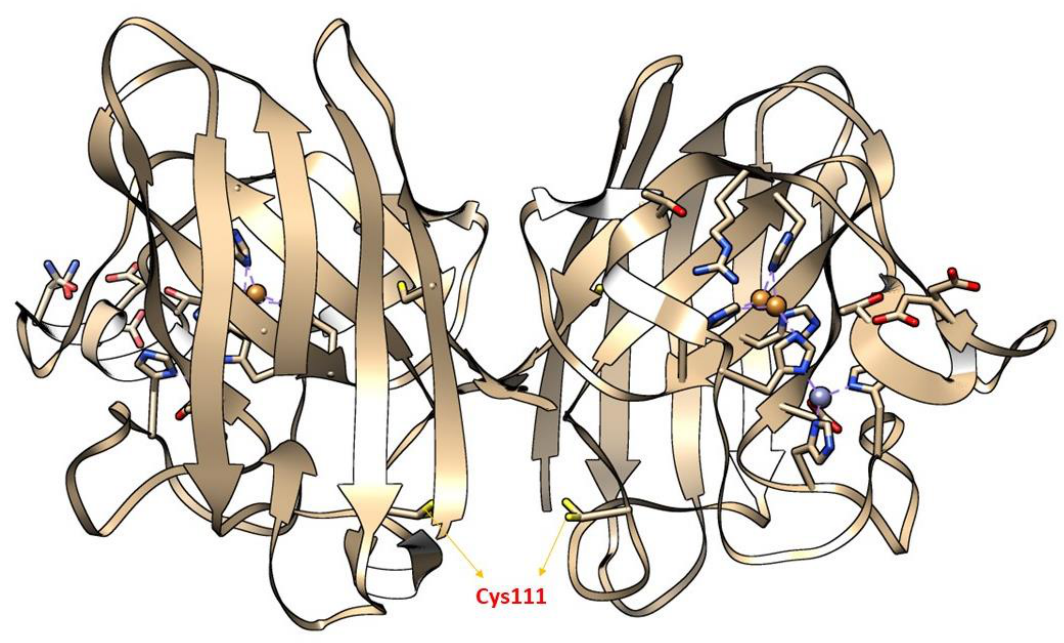
Figure 6. The X-ray crystallographic structure of wild-type SOD1 (wSOD1) (Pdb#2C9V) [211] is shown, modeled in Chi- mera. Cysteine 111( Cys 111 ) highlighted in the yellow act as a “HOT SPOT” for oxidative mo dification by hydrogen per- oxide (H 2 O 2 ) and labeled red in the cartoon. The Zinc (Zn) and Copper (Cu) atoms are shown in cyan and orange, respec- tively